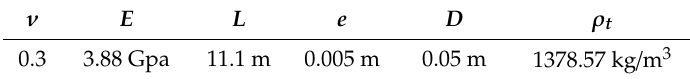
Figure 4. Schematic of water conveyance system with surge chamber. Table 1. Parameters of the experimental